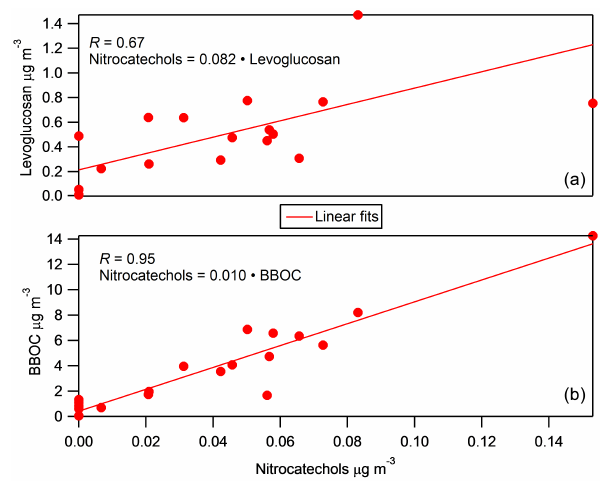
Figure 9. Correlation between the sum of nitrocatechols (Table S1) with levoglucosan and